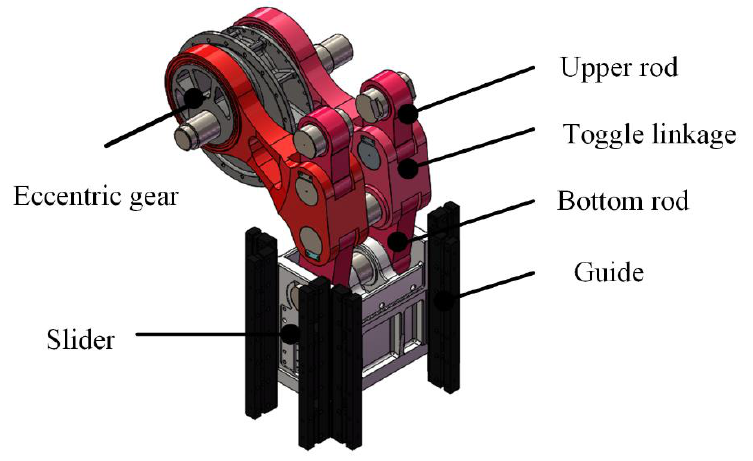
Figure 1. The toggle transmission mechanism with slider.